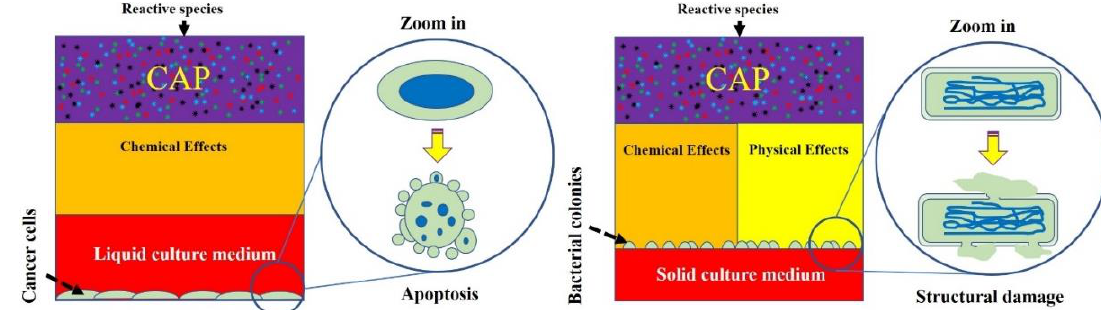
Figure 10. A schematic illustration of typical CAP treatment on cancer cells and bacteria in vitro. In most experimental setups in vitro, cancer cells or mammalian cells were immersed in a layer of medium during direct CAP treatment. In contrast, many bacterial cells were directly exposed to CAP because solid culture medium was widely used in many cases. Such a different experimental tradition may naturally filter the physical effectors of CAP in the studies involving liquid culture medium.